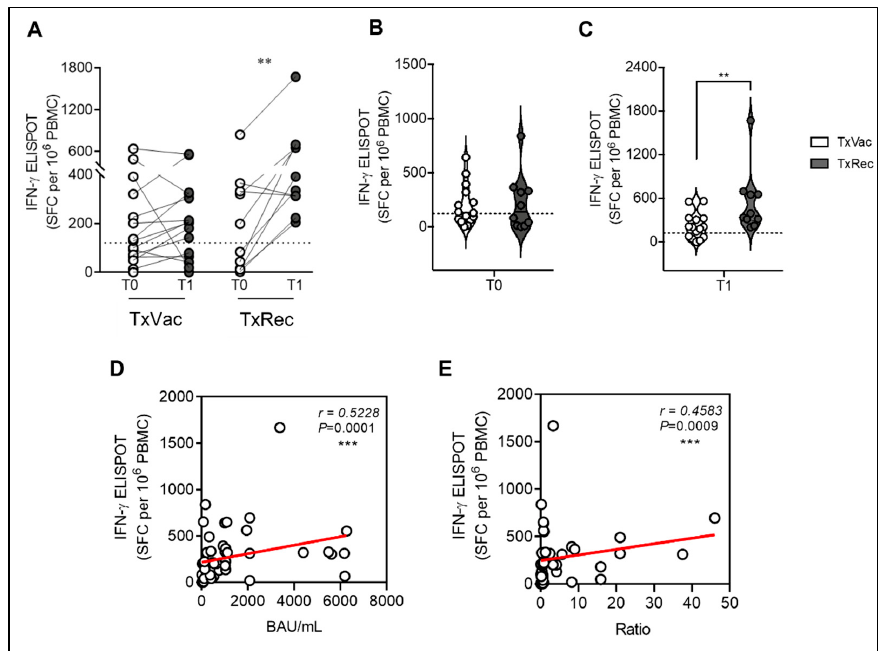
Figure 2. Cellular immune response to SARS-CoV-2 vaccination in SOTRs ( n = 25) after the third dose of the mRNA vaccine (T0), and alternately, after the administration of the fourth booster dose ( n = 15), or after the onset of the natural infection ( n = 10). ( A ) T-cell responses (IFN- γ ELISpot SFC per 10 6 PBMC) to Spike were compared between T0 (white dots) and T1 (grey dots), respectively after the fourth dose (TxVac) or after natural infection (TxRec). Each dot plot represents the normalized mean spot count from duplicate wells (2.5 ± 0.5 × 10 5 PBMC/well) for each subject, after subtraction of the spot count of unstimulated cells. IFN- γ ELISpot > 112 SFC/10 6 PBMC were considered